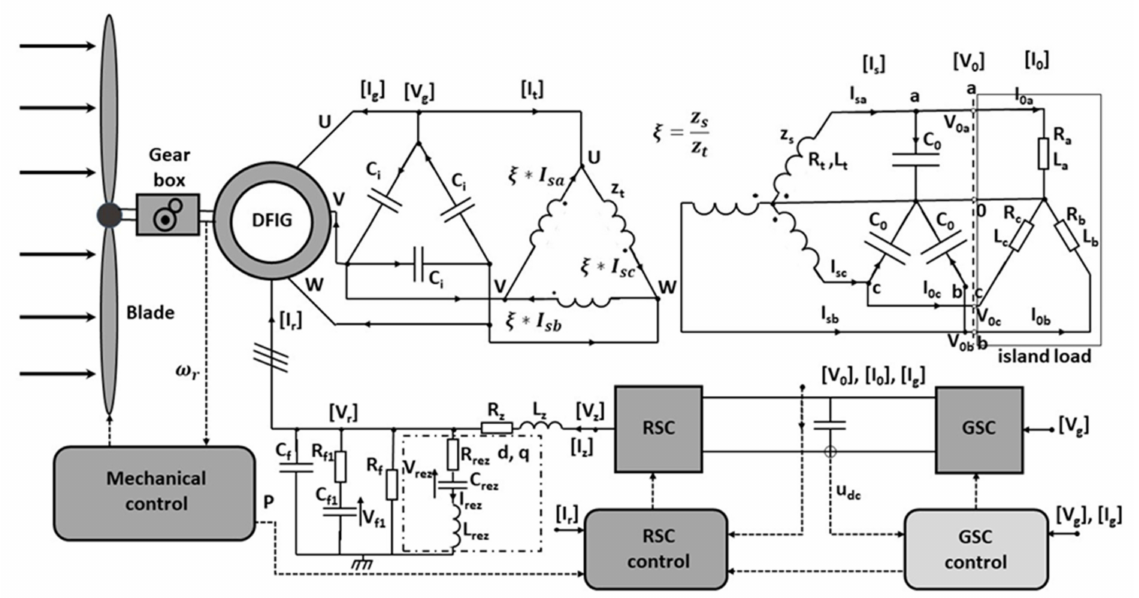
Figure 23. Control system of a wind turbine with a DFIG generator for island grid operation to accelerate the decay of rotor voltage oscillations V r and rotor current oscillations I r